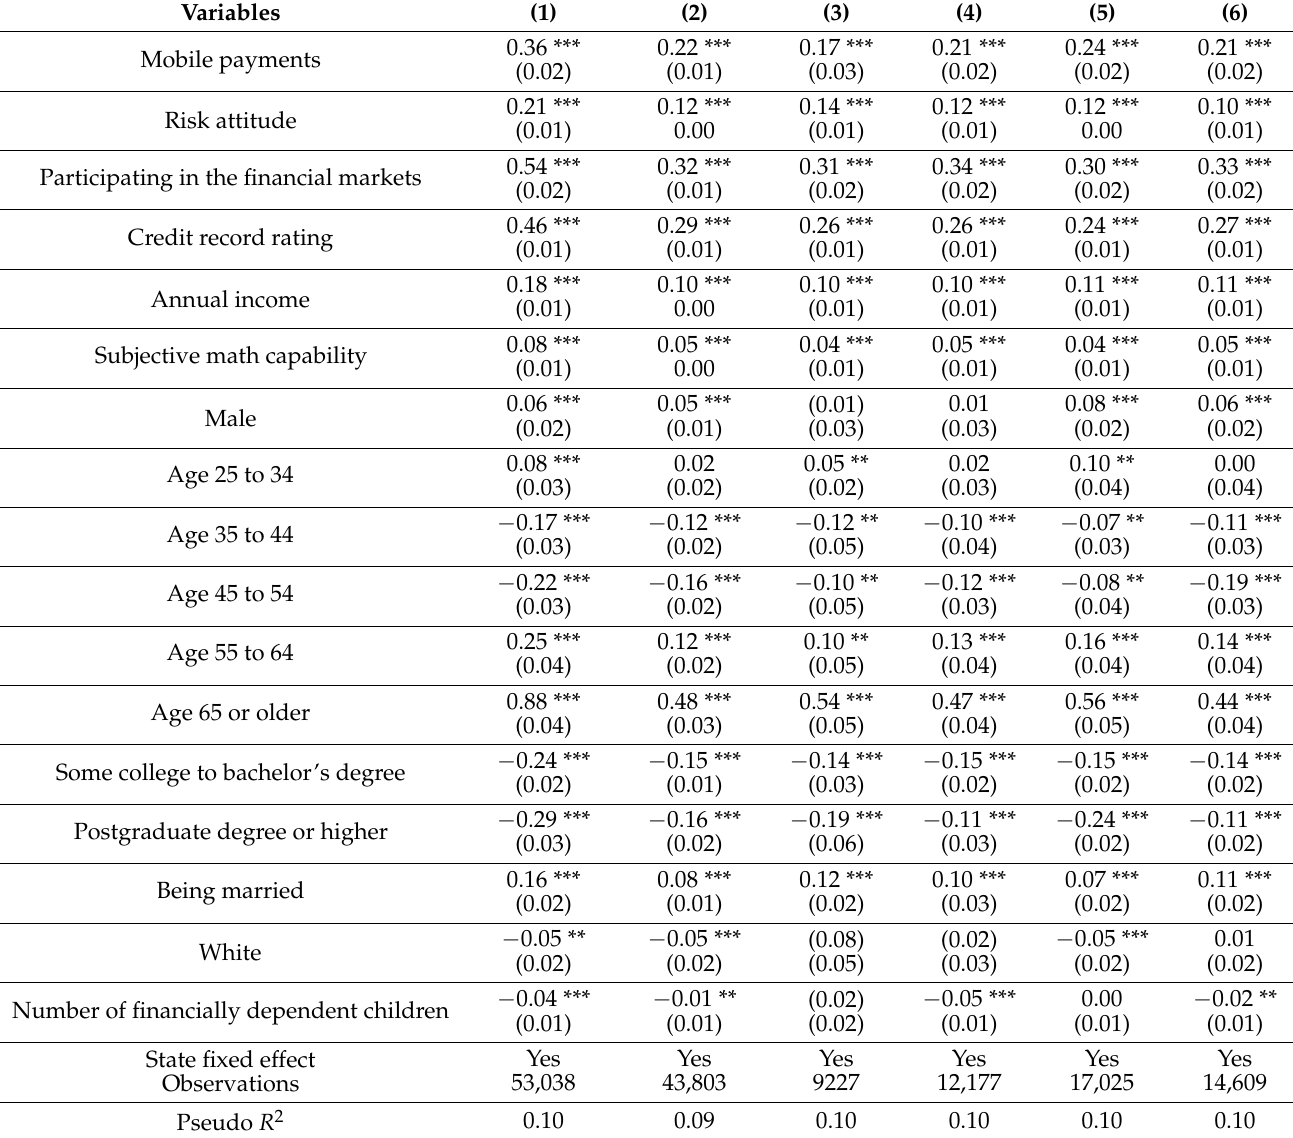
Table 5. Results of the robustness